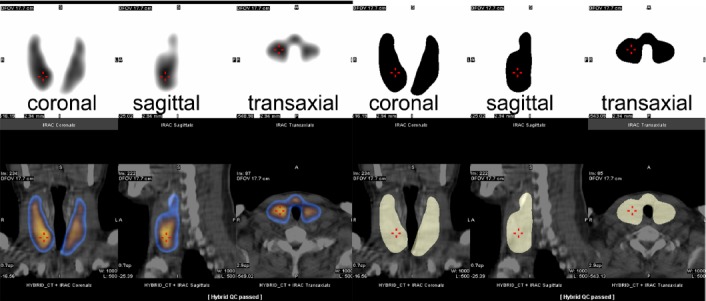
Simultaneously imaged slices of a diffuse enlarged thyroid in a patient with Graves’ disease (GD). Images on the top left show the pertechnetate image acquisition data including those of the coronal, sagittal, and transaxial slices. Images on the top right are the pertechnetate images processed using the SUV-shape scheme. Images at the bottom represent the fusion imaging of images in the top row and the corresponding low-dose CT images. The coronal slice shows the increased length and width of thyroid lobes, with both lobes extending from the superior border of thyroid cartilage to the superior border of clavicle. The sagittal slice shows the increased depth of the right lobe. The transaxial slice shows the enlarged isthmus of thyroid